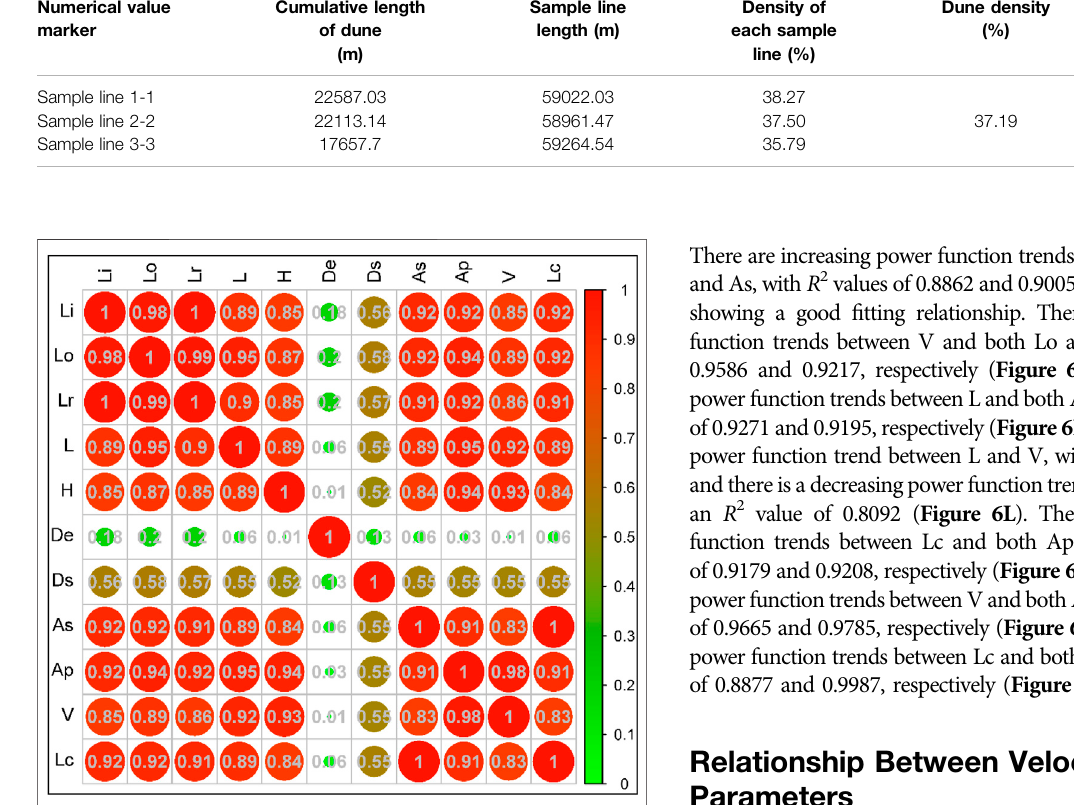
FIGURE 5 | Correlation analysis of the morphological parameters of the sand